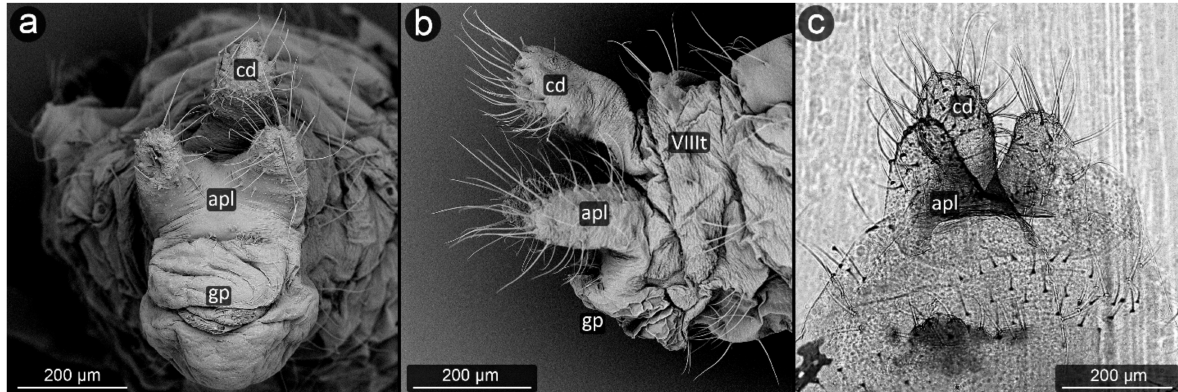
Figure 7. Perianal structure of Panaphis juglandis ; ( a )—rear view (SEM), ( b )—lateral view (SEM), ( c )— rear view in light microscopy.